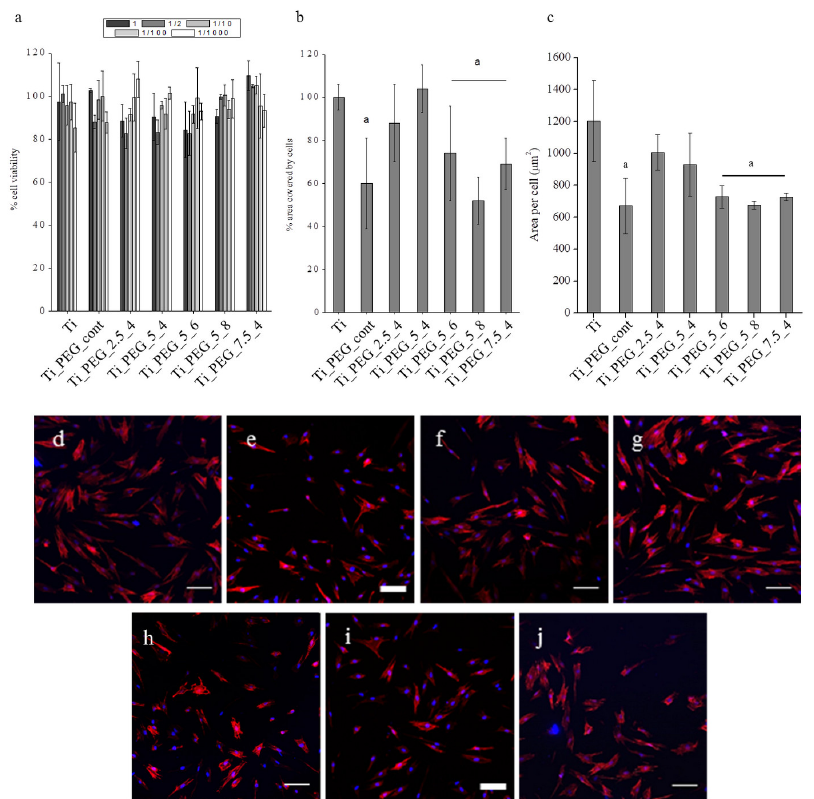
Figure 4. Indirect cytotoxicity of the PEG-coated samples ( a ), % area covered by cells ( b ) and area per cell (c). Samples with the same symbol have no statistically significant differences p < 0.05) ( c ). Cell adhesion on the samples: Ti ( d ), Ti_PEG_cont ( e ), Ti_PEG_2.5_4 ( f ), Ti_PEG_5_4 ( g ), Ti_PEG_5_6 ( h ), Ti_PEG_5_8 ( i ), and Ti_PEG_7.5_4 ( j ). Scale bar indicates 100 µ m.